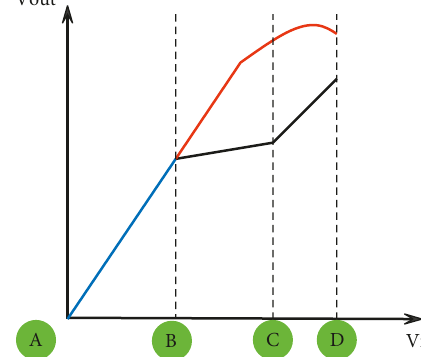
Figure 2: AGC input and output transmission